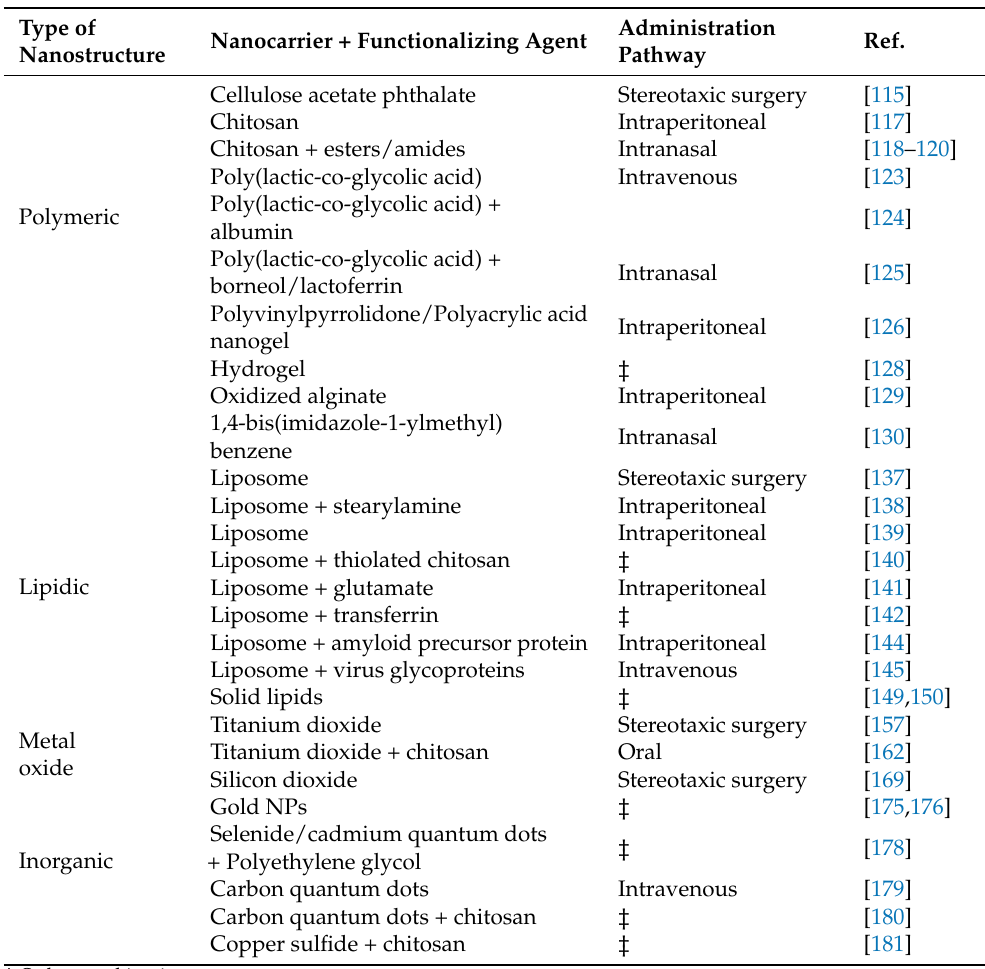
Table 1. Nanocarriers tested for controlled DA